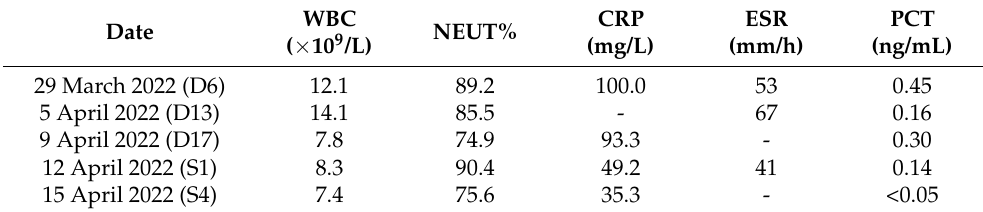
Table 1. Trend of the WBC and Inflammatory indicators.